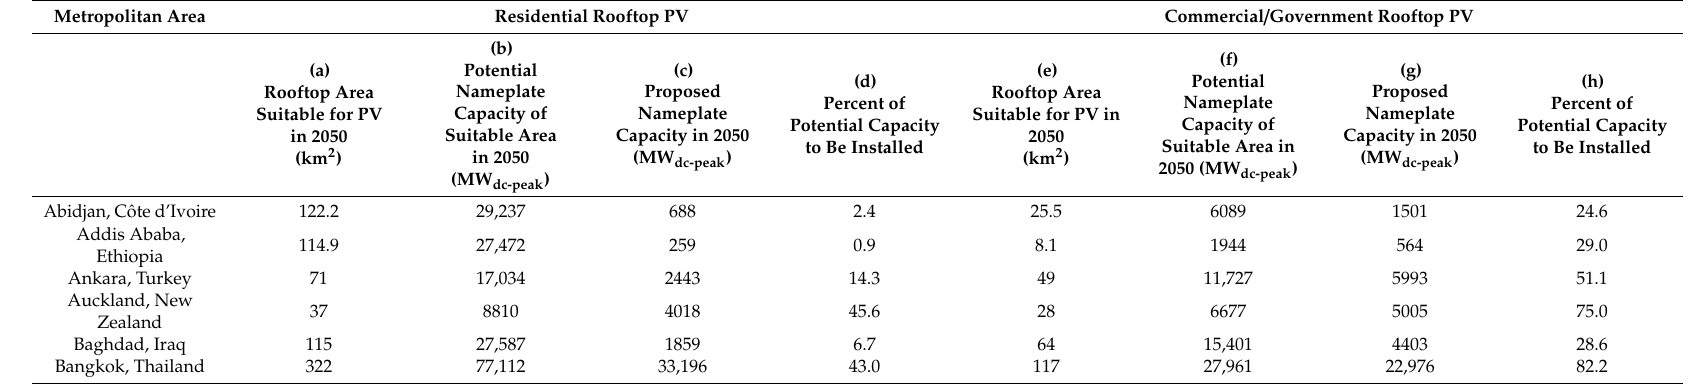
Table 6. Year 2050 ( a , e ) rooftop areas suitable for photovoltaics (PV) panels, ( b , f ) potential nameplate capacities of suitable rooftop areas, ( c , g ) proposed nameplate capacities for 2050, and ( d , h ) percent of potential capacity to be installed (proposed capacity divided by potential capacity) for both residential and commercial / government